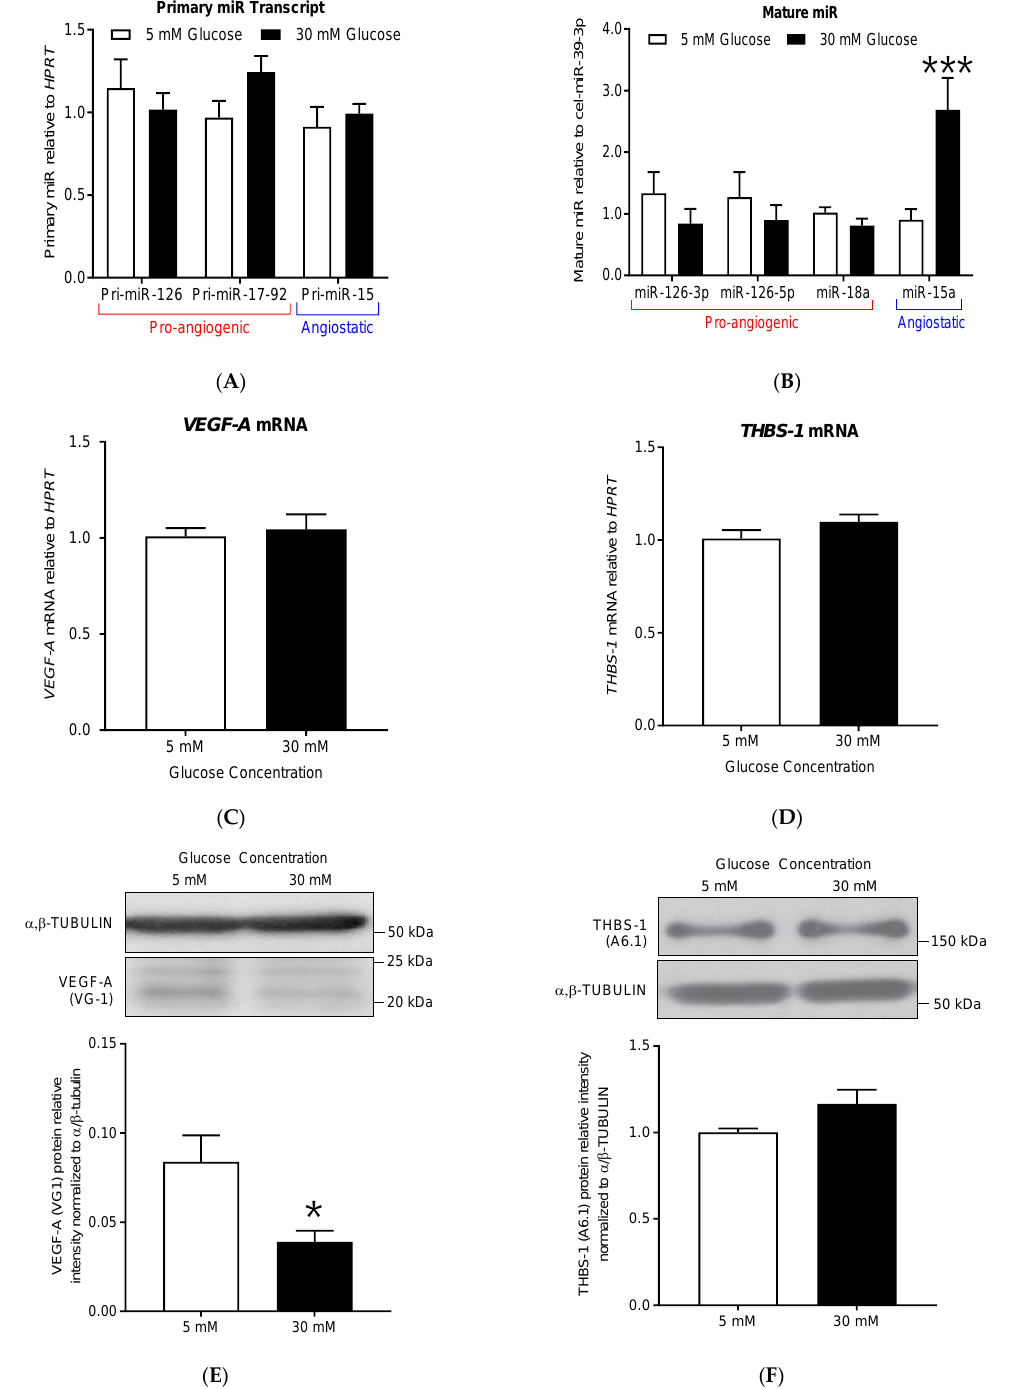
Figure 3. High glucose treatment shifted endothelial cell angiomiR expression towards an anti-angiogenic phenotype. ( A ) Primary miR and ( B ) mature miR levels relative to HPRT housekeeping gene and exogenous spike-in cel-miR-39-3p, respectively. Pro-angiogenic pri-miRs and miR are underlined in red, while angiostatic pri-miRs and miRs are underlined in blue. Data are means ± SEM ( n = 6). Two-way ANOVA showed no effect of glucose concentration on the expression of pri-miR-126, pri-miR-17-92, and pri-miR-15; *** indicates significative difference compared to 5 mM of glucose ( p < 0.001)). ( C,D ) VEGF-A and THBS-1 mRNA relative to HPRT in HDMEC treated with 5 or 30 mM glucose concentrations for 24 h (data are means ± SEM, n = 9). ( E,F ) Immunoblots of miR targets VEGF-A and THBS-1 (A6.1) after 24 h treatment under 5 or 30 mM glucose conditions. α,β-TUBULIN was used as a loading control. Data are means ± SEM; * indicates significative differences ( p < 0.05, t -test, n = 5-10).